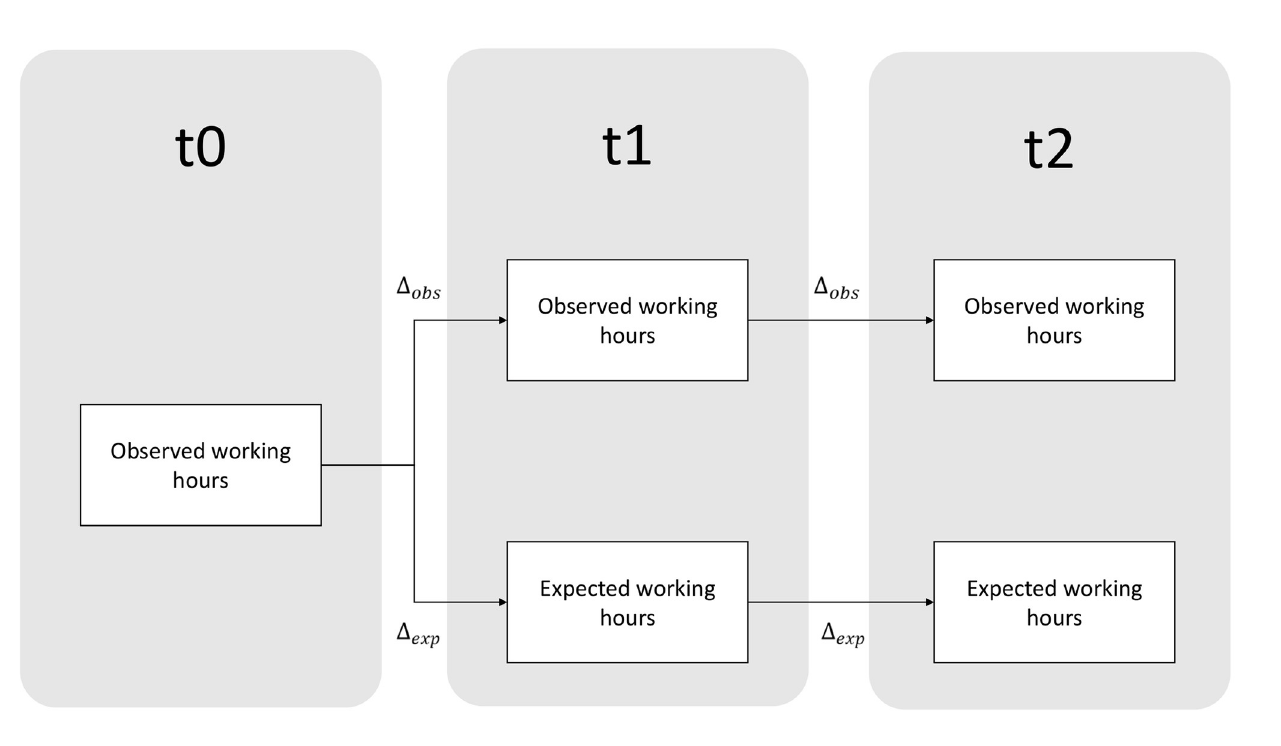
Fig 1. Diagram of time periods and changes